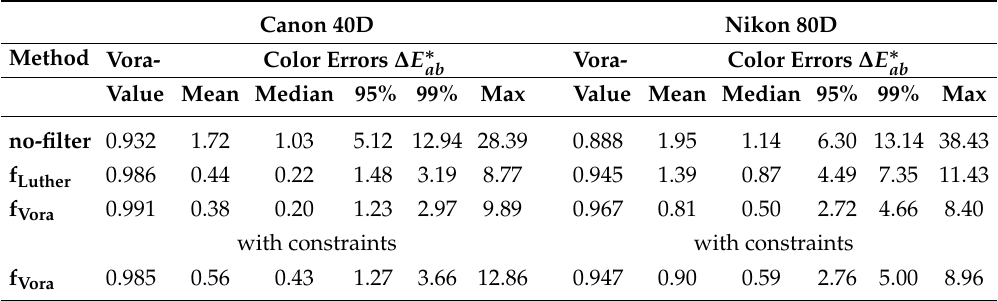
Table 1. Error statistics of the color corrected native camera with no-filter , the color corrected camera with the filters obtained from the sensitivity targets of the color matching functions f Luther and of